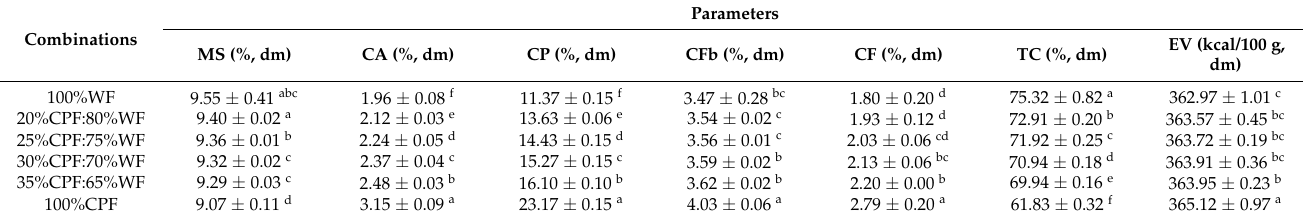
Table 1. Physicochemical composition of durum wheat flour, fortified durum wheat flour, and chickpea